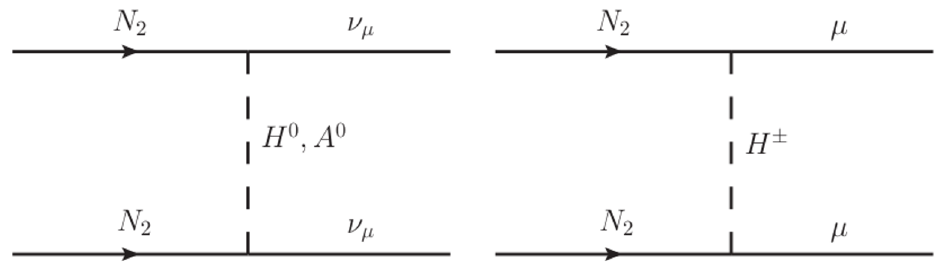
Figure 35 . Subleading contributions to the relic.